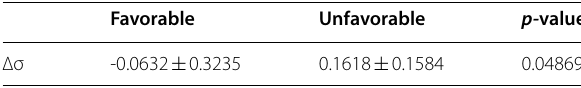
Table 4 Distribution of average ∆σ values